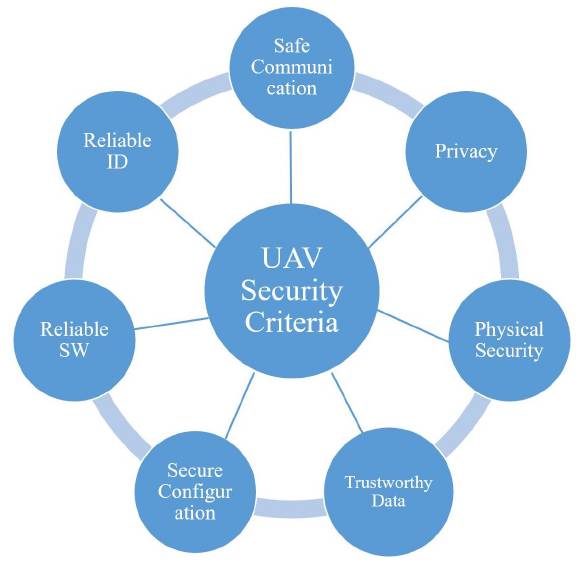
Figure 9. UAV security